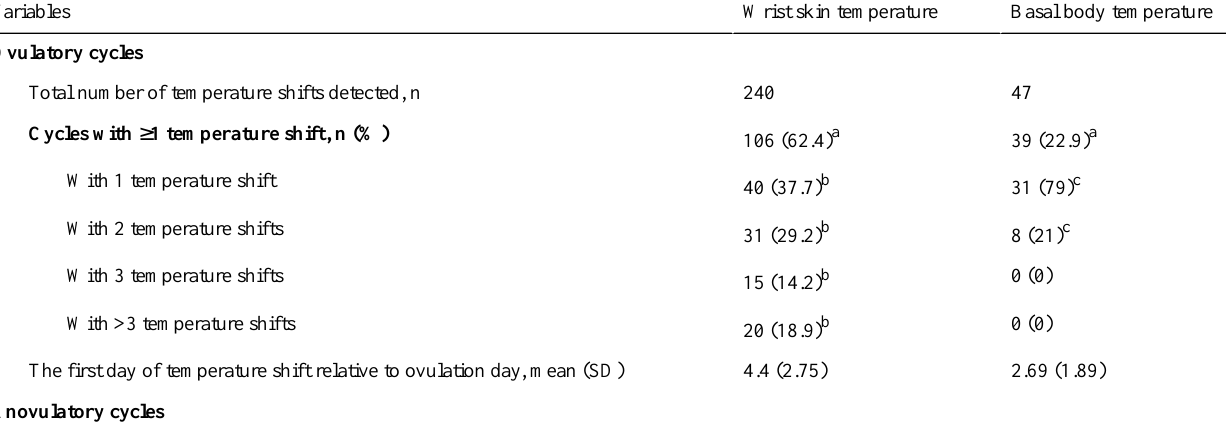
Table 2. Temperature shifts and diagnostic accuracy for wrist skin temperature and basal body temperature. Ovulatory